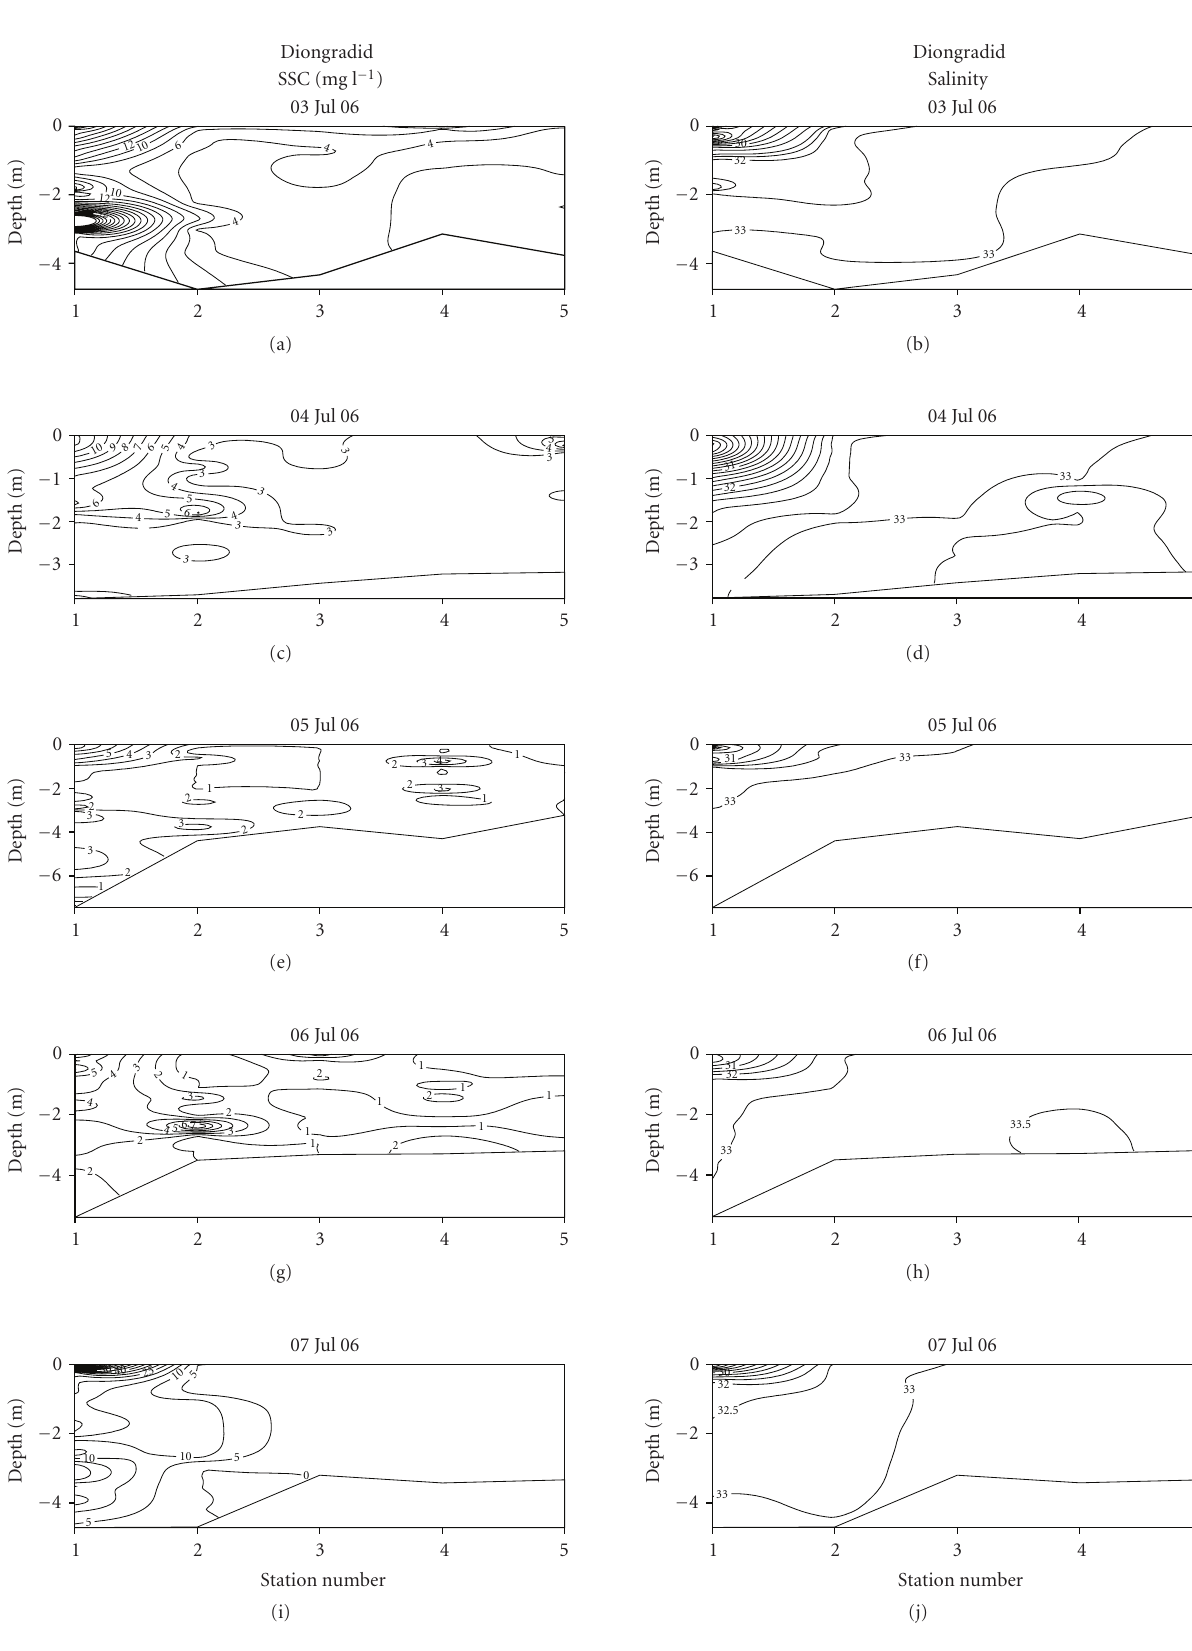
Figure 4: Snapshots at daily intervals of the two-dimensional distribution along the channel of salinity and SSC at Diongradid from CTD casts. The bottom line indicates the sea